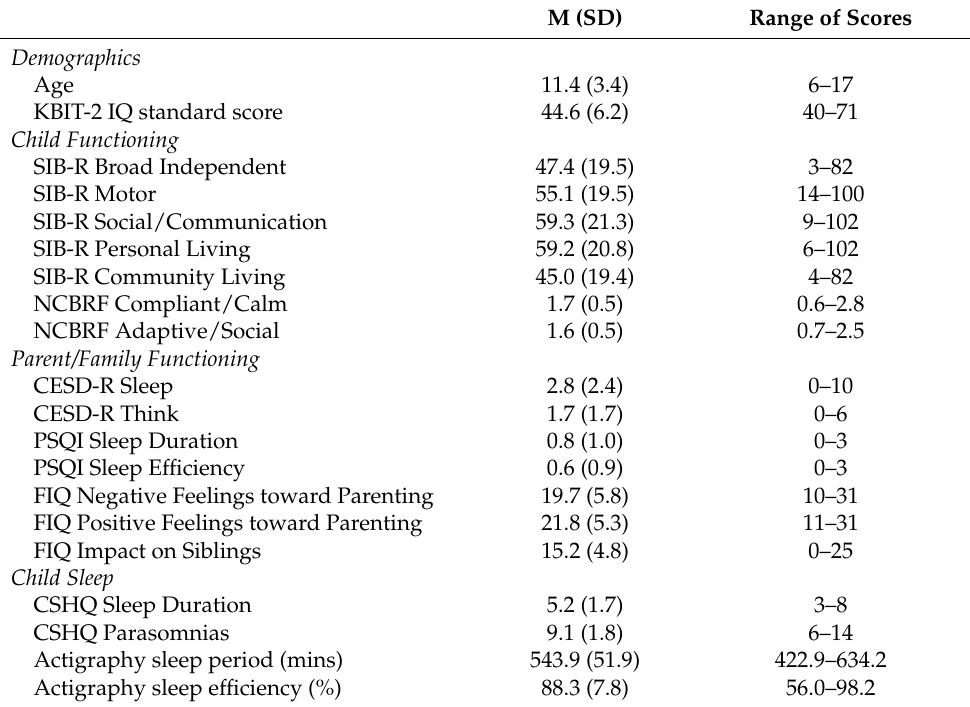
Table 1. Participant demographics and descriptive statistics for child functioning, parent/family functioning, and child sleep.